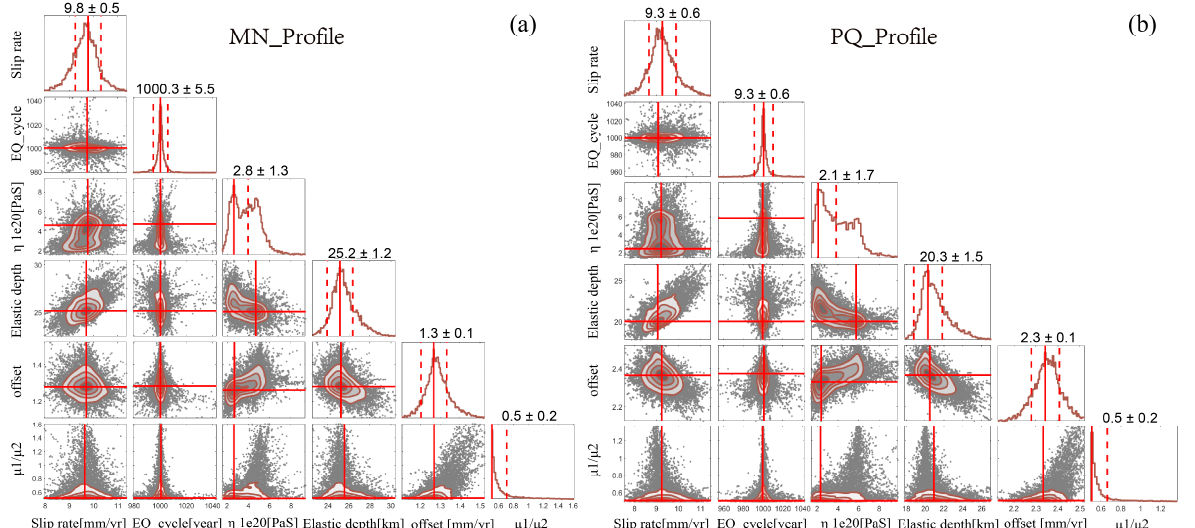
Figure A2. Maximum a posteriori probability (MAP) solution for profiles MN ( a ) and PQ ( b ). With the model, it has the same elastic thickness but different elastic shear modulus on both sides of the fault.